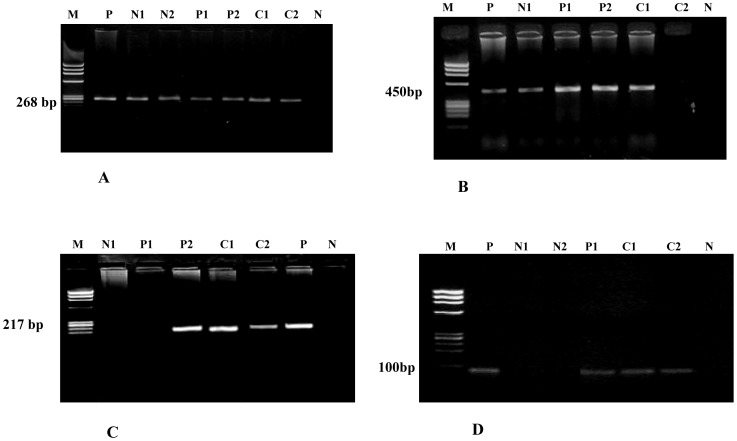
Detection of Human Papilloma virus genotypes 16 and 18 in precancer & cervical cancer patients by In vitro nucleic acid amplification test.(A) β-globin, 288bp (B) HPV-L1, 450bp (C) HPV-16, 217bp (D) HPV-18, 100bp as indicated in Materials and Methods section.